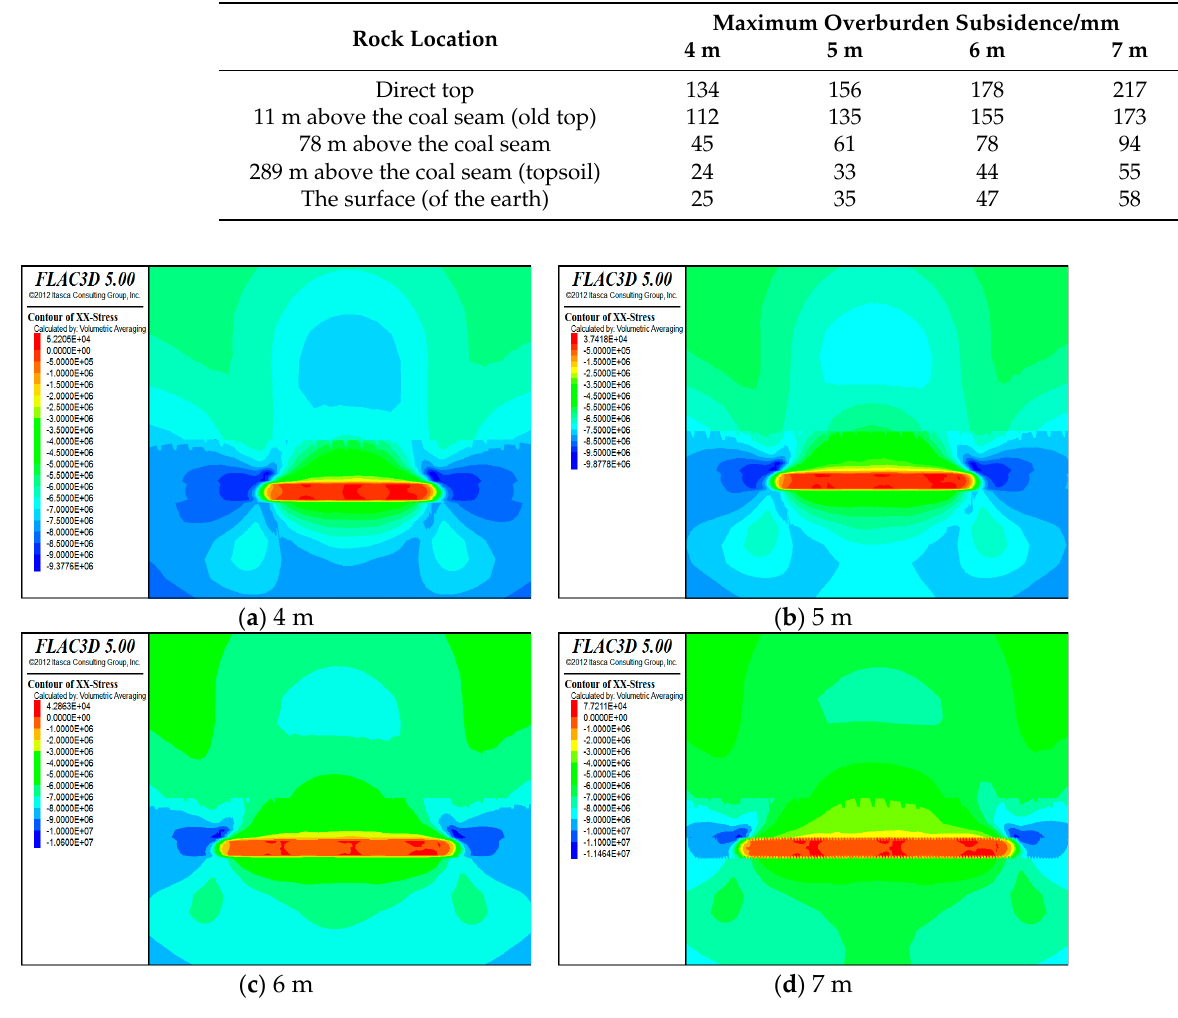
Figure 14. Horizontal stress distribution cloud for ( a ) 4 m, ( b ) 5 m, ( c ) 6 m, and ( d ) 7 m.